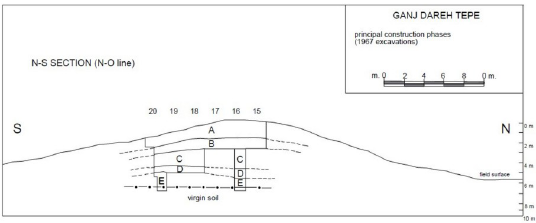
Fig 1. Unpublished N-S profile of the excavations at Ganj Dareh in